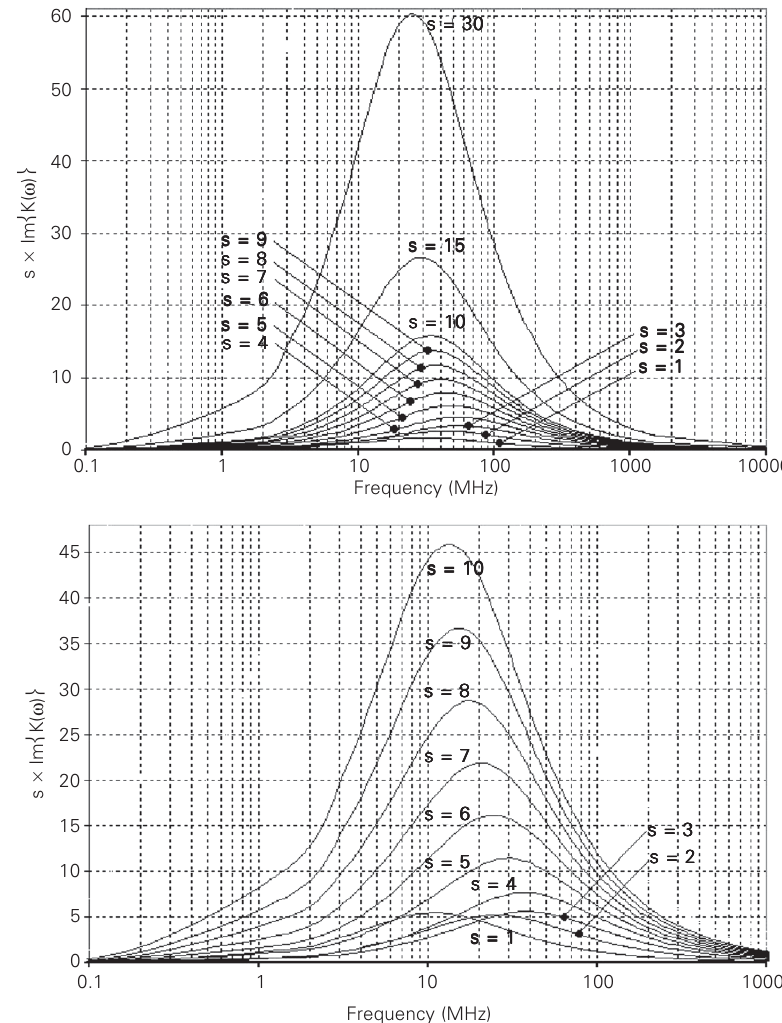
Figure 3. A , Electro-rotation spectra of erythrocyte rouleaux of different lengths (cid:65) = s x 2L , at medium conductivity σ m = 100 mS/m . 2L = 2.2 µm is the thick- ness of a single erythrocyte. The vertical axis displays a measure of the acting torque. Only the spectral range of positive torque is shown, where no membrane effects are involved. Cytoplasm parameters are ε p = 50 and σ p = 0.535 S/m . B , Same as A , but the medium conductivity is re- duced to σ m = 1 mS/m . The maximum torque on the par- ticles is increased up to a factor of